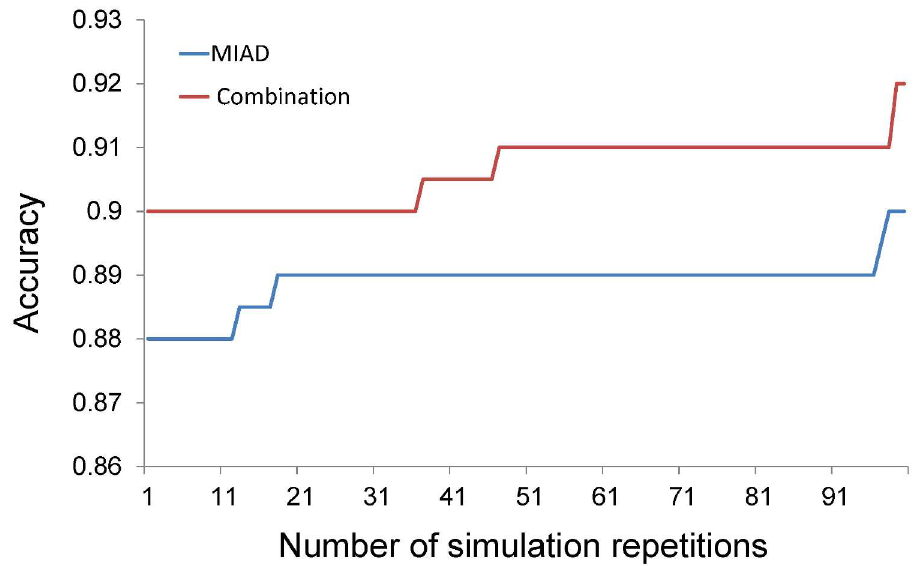
Fig 9. Bootstrap sampling method for comparing the stage II parameter combination versus the MIAD alone. Comparison of the combination method and the MIAD alone by sampling100 cases and simulating 100 repetitionsto obtain the median of accuracy and plot the line chart (if the samplingdata have a Gaussian distribution, then the mediancan be replaced by the mean; thus, t = 42.57 and p < 10 − 64 ). MIAD, minimal axial diameter; MAAD, maximal axial diameter; MACD, maximal coronal diameter; NSUVmean, nodal mean standard uptake